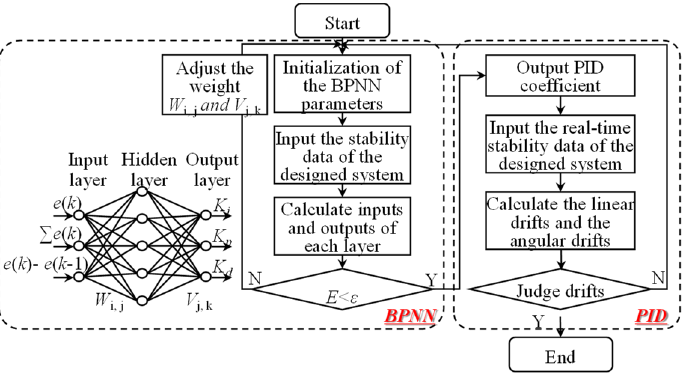
Figure 8. The flowchart of the BPNN-based PID controller.